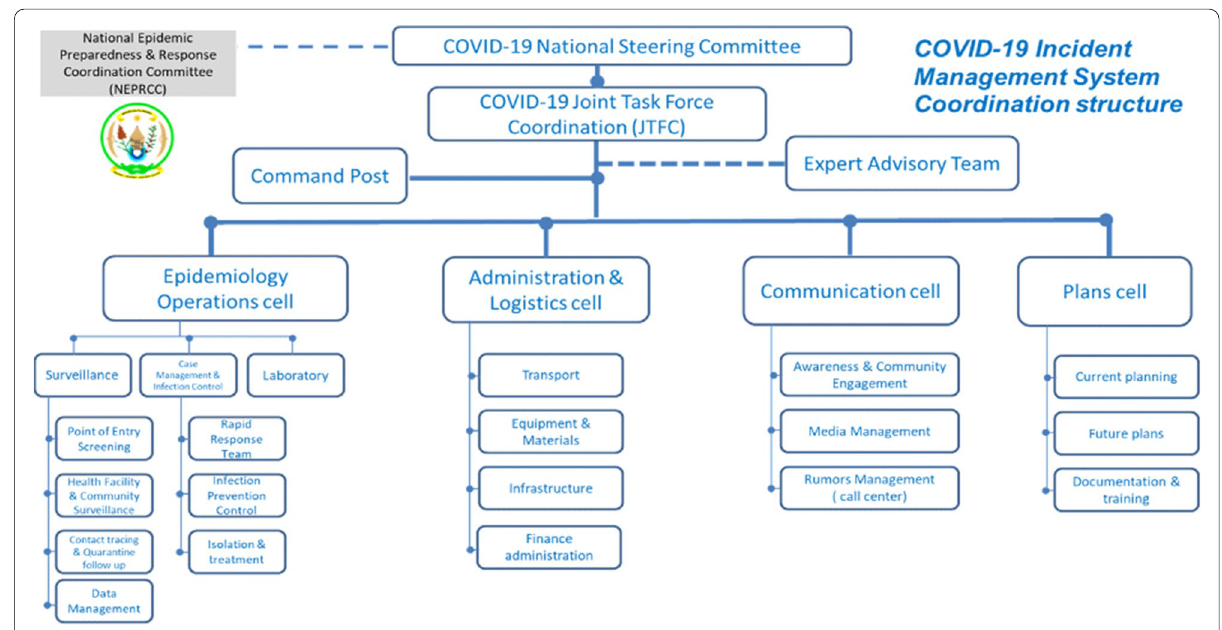
Fig. 4 Rwanda’s COVID-19 multisectoral response structure